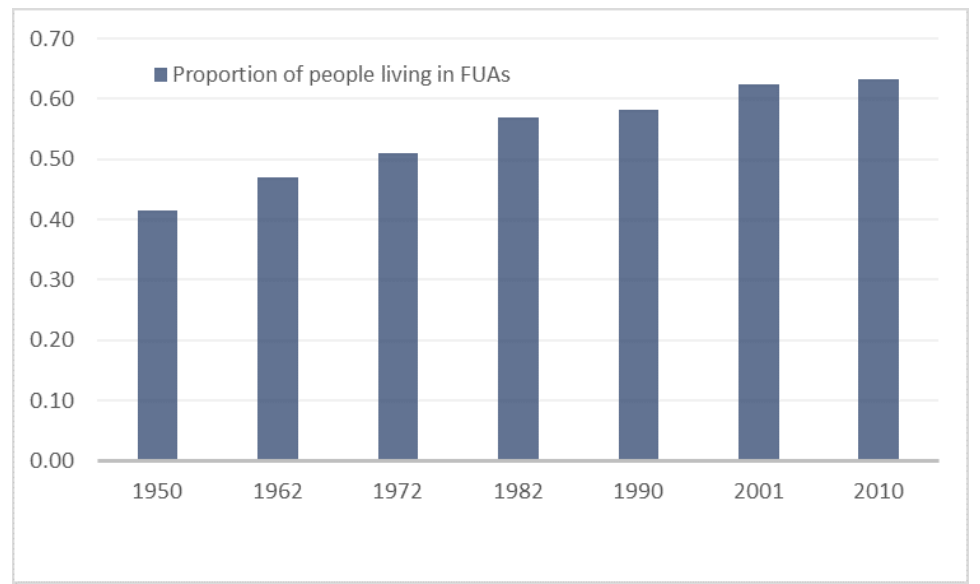
Figure 3: Population living in the